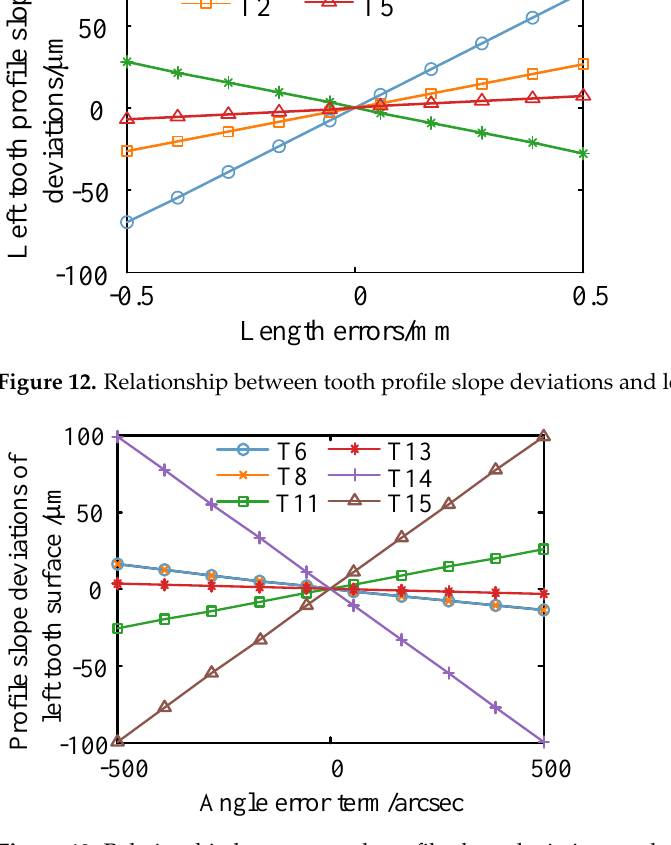
Figure 13. Relationship between tooth profile slope deviations and angle errors.